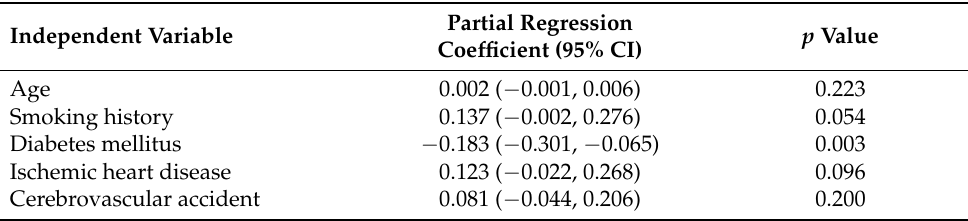
Table 3. Multiple linear regression analysis of the predicted changes in the diameter of the inflow artery from the arteriovenous access after brachial plexus block.